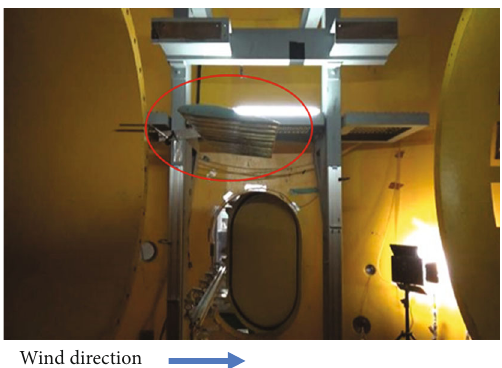
Figure 13: The picture of test model fl ying in the wind tunnel at a dynamic pressure of 60 Pa and RA of -4